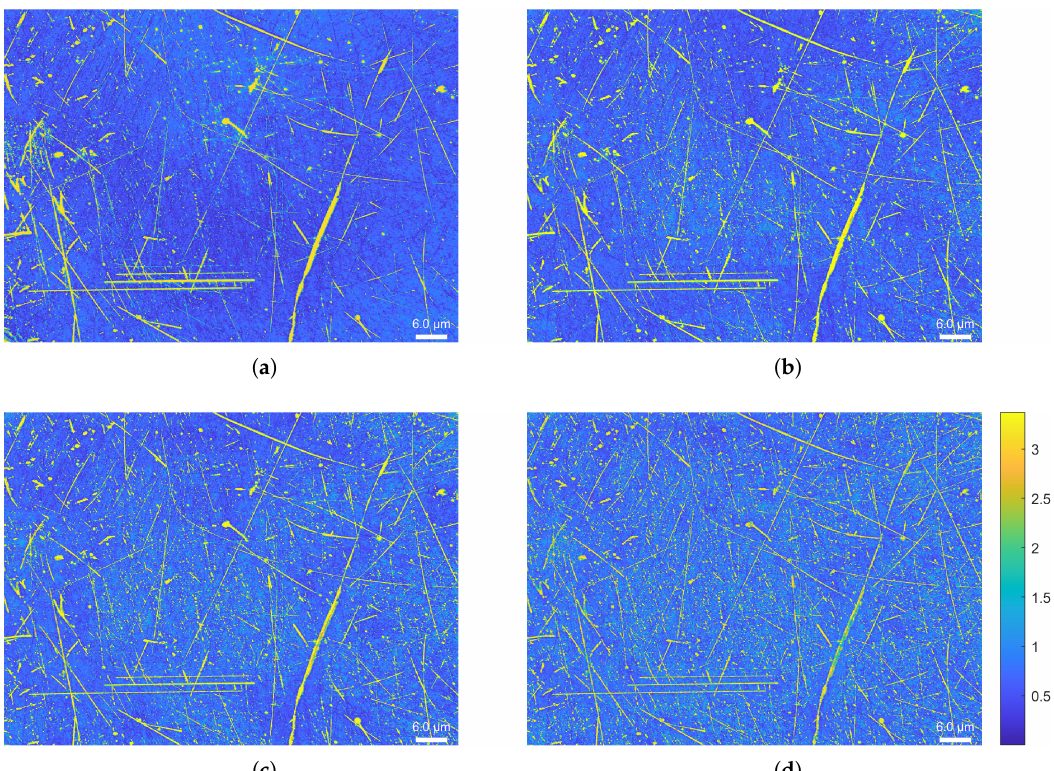
Figure 10. Scale factor saliency maps estimated with the statistics descriptors calculated from an RTI acquisition of the watch face: ( a ) Saliency map Global ; ( b ) Saliency map [ Si ; Tr ; St ] = [ 512;256;3 ] ; ( c ) Saliency map [ Si ; Tr ; St ] = [ 256;128;3 ] ; ( d ) Saliency map [ Si ; Tr ; St ] = [ 128;64;3 ] . Similar to multi-level saliency, it is possible to calculate multi-scale saliency from several scale factor saliency measurements, as described in Equation (5) and shown in Figure 11.